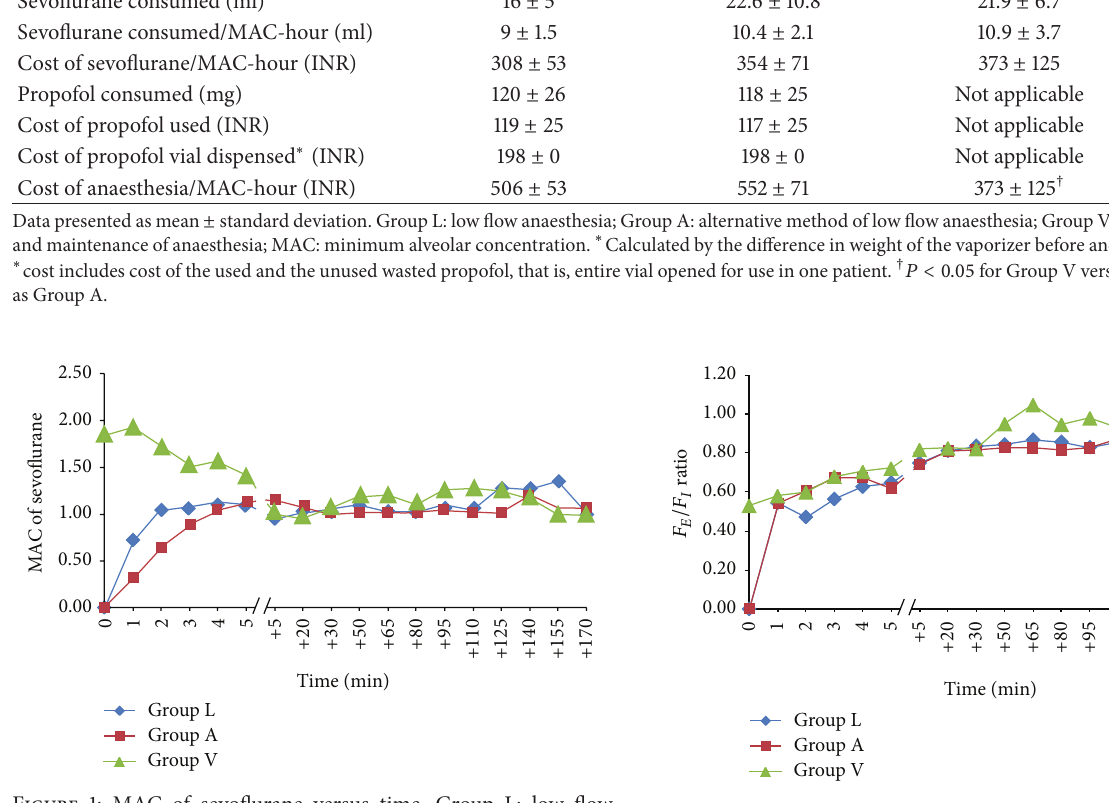
Figure 2: 𝐹 𝐸 /𝐹 𝐼 ratio versus time. 𝐹 𝐸 : end-tidal concentration of sevoflurane and 𝐹 𝐼 : inspired concentration of sevoflurane; Group L: low flow anaesthesia, Group A = alternative method of low flow anaesthesia, and Group V = volatile induction and maintenance of